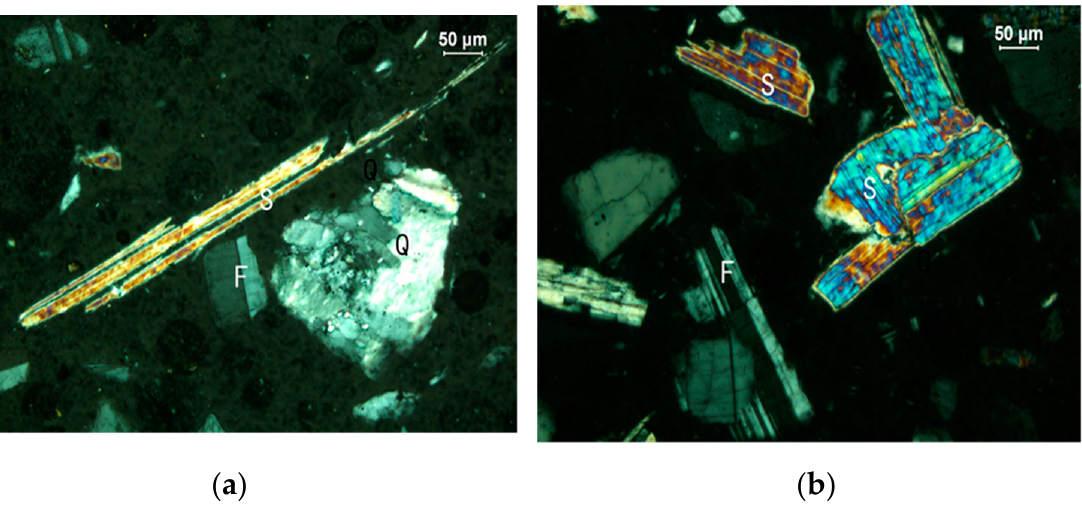
Figure 6. Orthogonal polarization diagram of mica (S), albite (F), and quartz (Q): ( a ) mica exists in the form of thin strips; ( b ) mica exists in the form of